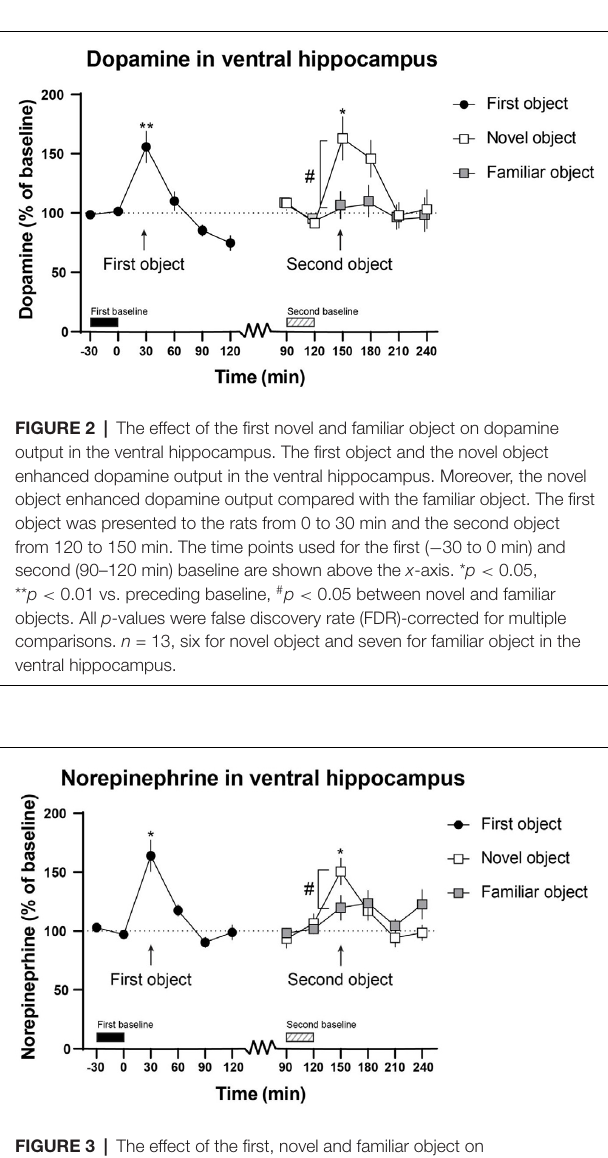
FIGURE 3 | The effect of the first, novel and familiar object on norepinephrine output in the ventral hippocampus. The first and the novel object significantly increased norepinephrine output in the ventral hippocampus. Moreover, the norepinephrine output in the ventral hippocampus was significantly higher in the rats presented with the novel object compared with the rats presented with the familiar object. The first object was presented to the rats from 0 to 30 min and the second object from 120 to 150 min. The time points used for the first ( − 30 to 0 min) and second (90–120 min) baseline are shown above the x -axis. * p < 0.05 vs. preceding baseline, # p < 0.05 between novel and familiar objects. All p -values were false discovery rate (FDR)-corrected for multiple comparisons. n = 13, six for novel object and seven for familiar object in the ventral hippocampus.